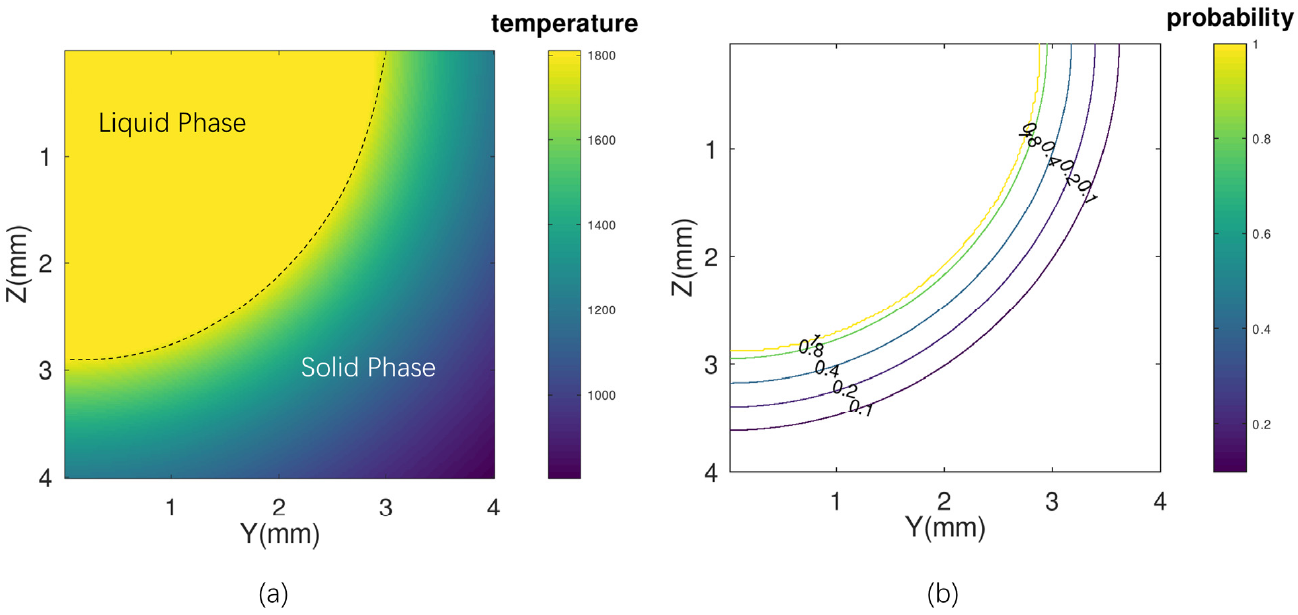
Figure 5. Computed values of ( a ) spatial distribution of temperature and ( b ) site selection probability in the cross-sectional plane of the weld of low-carbon steel.